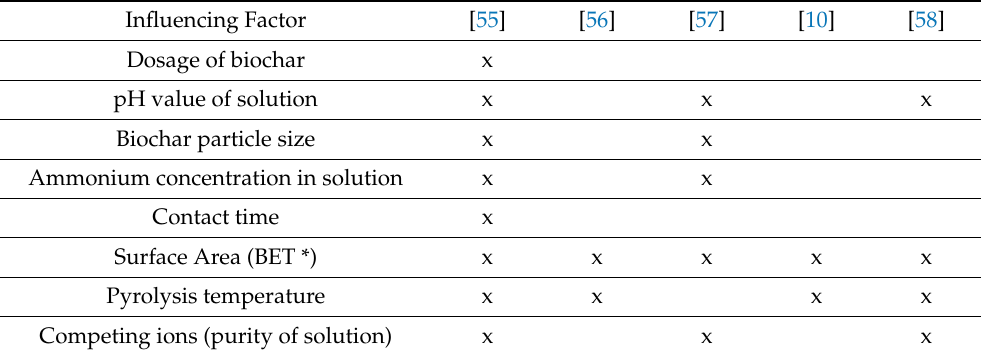
Table 1. Data collection of influencing factors for ammonium adsorption onto biochar from different review